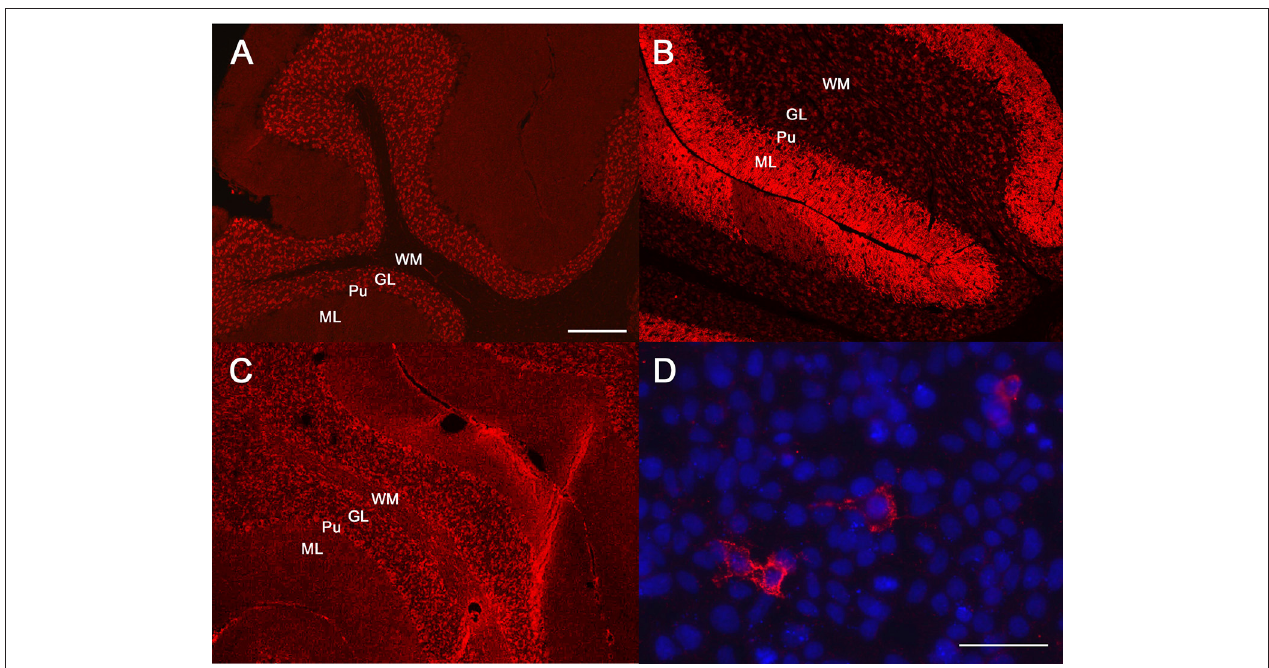
FIGURE 1 | Antibody diagnostics. Immunofluorescence studies: diluted patient material is incubated with mouse brain sections or human embryonic kidney (HEK) cells transfected with the antigens of interest. Binding of patient antibodies to the respective matrix is visualized by a secondary anti-human/canine antibody coupled with an immunofluorescence dye resulting in a red signal. (A–C) Tissue-based assays, mouse cerebellum. (D) cell-based assay with HEK cells which were transfected with the γ -aminobutyric acid (GABA)-A receptor (GABA A R) subunits α 1 β 3 (all assays from Euroimmun, Lübeck, Germany). Molecular layer (ML), purkinje cell layer (Pu), granular cell layer (GL), white matter (WM). (A) Human antibodies against the GABA A R. (B) Human antibodies against the GABA B R. (C) The canine antibodies against the GABA A R. Please note that the binding pattern is similar to (A) and not to (B) . (D) The canine serum binds to GABA A R transfected HEK cells. Nuclear counterstaining with Hoechst 33342 in blue. Bar in (A) , valid also for (B,C) : 100 µ m. Bar in (D) : 25 µ m.